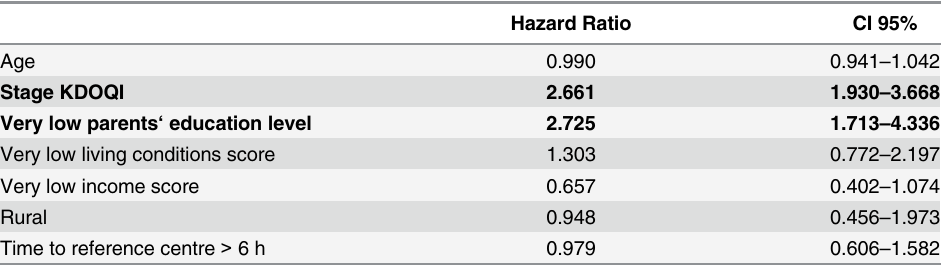
Table 5. Cox regression